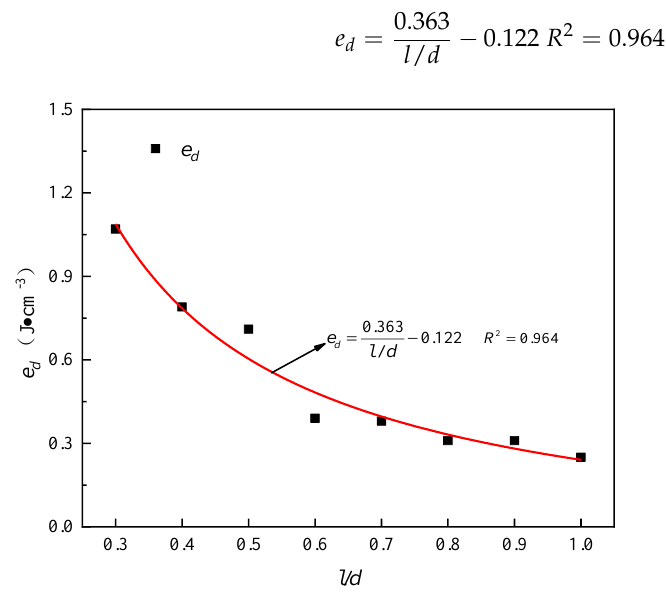
Figure 9. Variation law of dynamic compression energy consumption density of coal with different l / d .